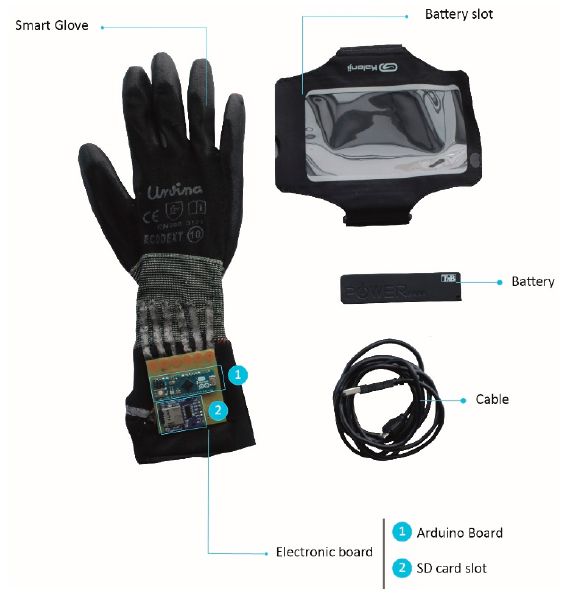
Figure 10. Final glove prototype.